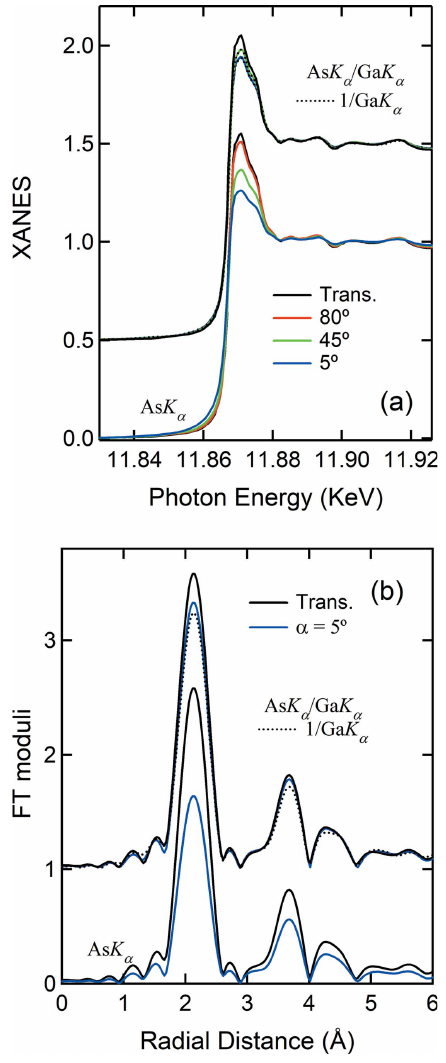
Figure 7 XAS spectra measured on GaAs wafer through the As K (cid:5) and Ga K (cid:5) channels at the As K -edge. All compared with the standard (black line). ( a ) Lower: XANES from As K (cid:5) at (cid:5) = 5 (cid:3) , 45 (cid:3) , and 80 (cid:3) . Upper: XANES from 1/Ga K (cid:5) and As K (cid:5) /Ga K (cid:5) , (cid:5) = 5 (cid:3) and 45 (cid:3) . ( b ) The FT moduli of the corresponding EXAFS spectra ( k = 3–12.4 A˚ (cid:6) 1 , Hanning